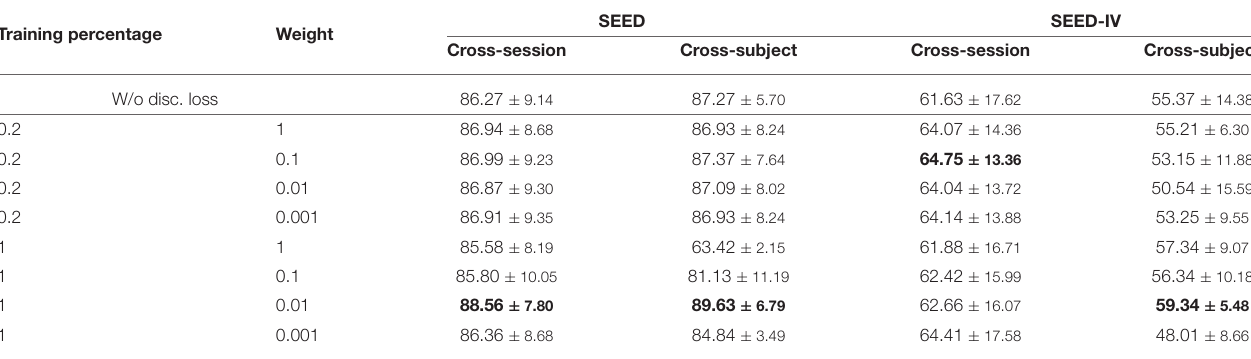
TABLE 5 | Performance of MS-MDA on SEED and SEED-IV of accuracy with different settings of β . Training percentage